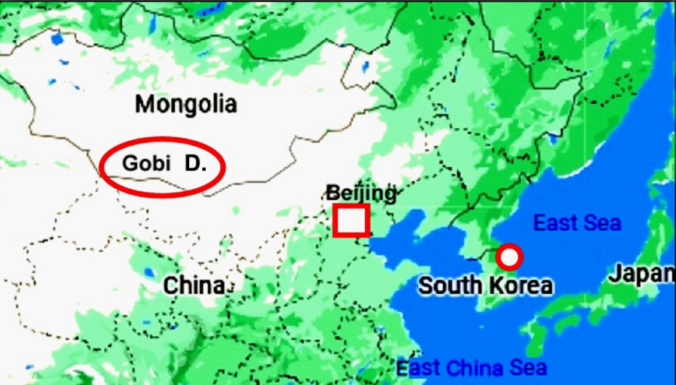
Figure 1. Topographical feature in the north-eastern Asia including the Gobi Desert (large red ellipse), Beijing city (China; red square) and Gangneung city (Korea; small red